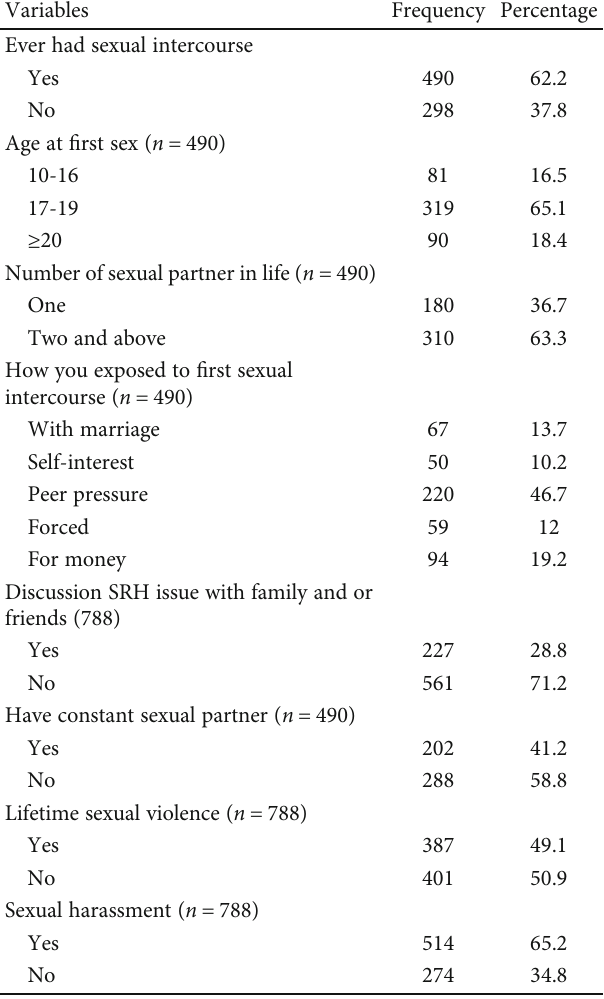
Table 2: Sexual characteristic of female night students in public institution of Bahir Dar city, Amhara Region, Ethiopia,